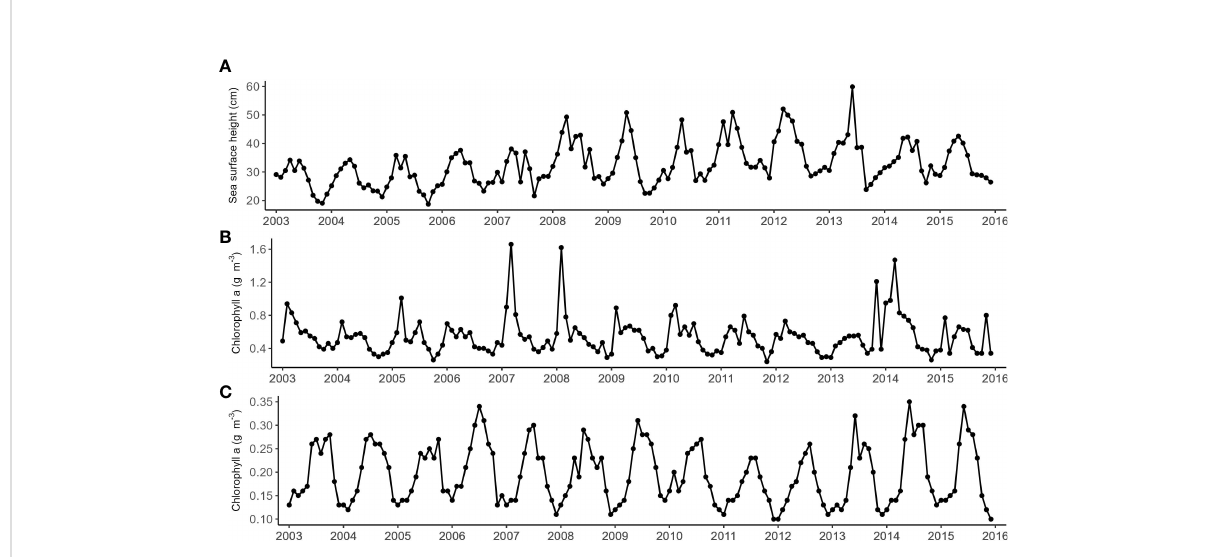
FIGURE 4 Monthly time series of (A) Sea surface height measured at Cape Leeuwin obtained from the AVISO multi-satellited mission. Chlorophyll-a obtained from Modis Aqua from the NOAA Ocean Watch - Central Paci fi c Program (B) measured at Cape Leeuwin, and (C) measured at the Bonney Upwelling. All variables were averaged from a 1° x 1° latitude and longitude grid at each